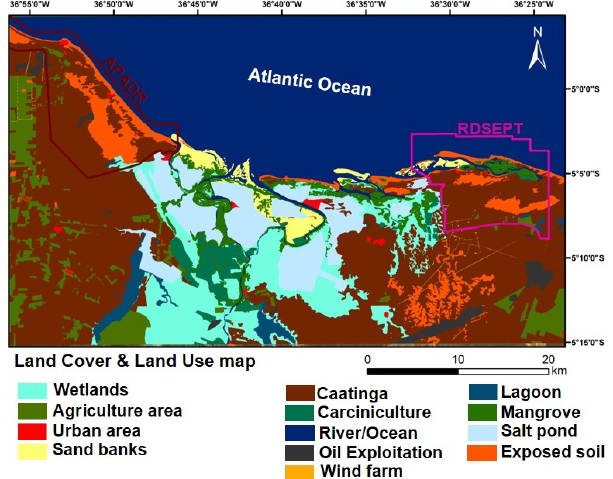
Figure 9. Land cover and land use map for study area.